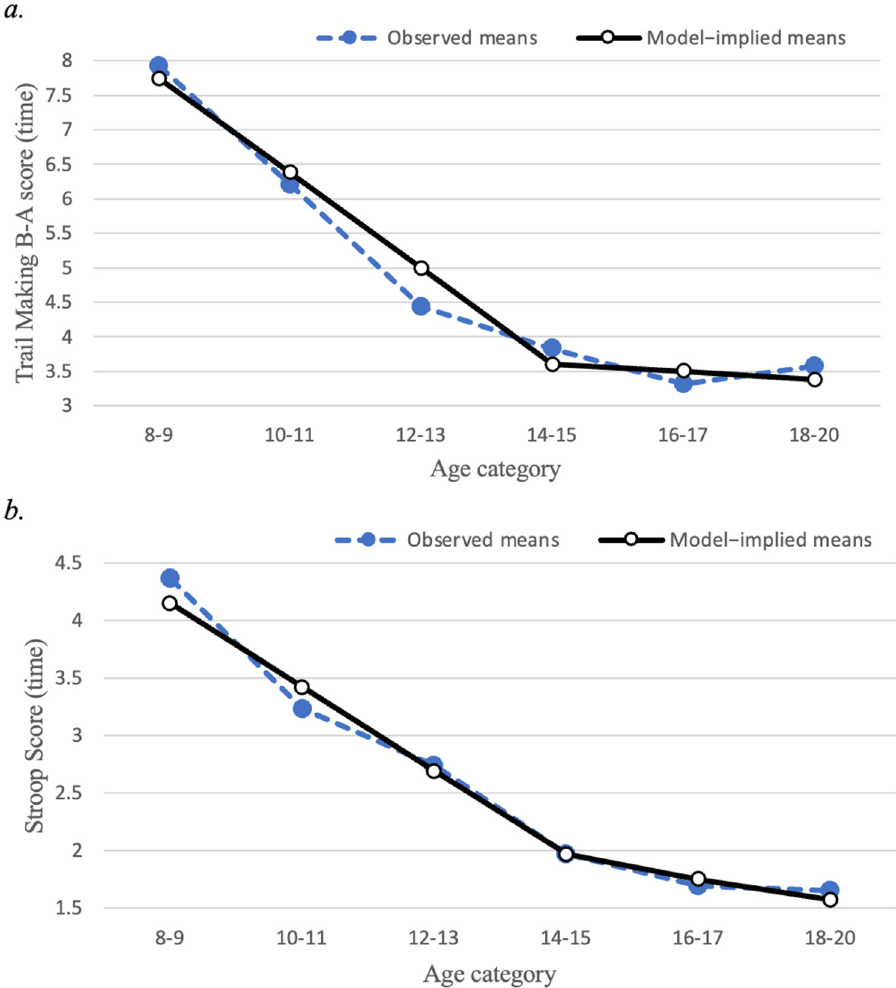
Figure 3. Mean trajectories for executive function task performance ( a ) Trajectory of Trail Making Task Part B minus Part A time; ( b ) Trajectory of Stroop Task interference time. Closed circles represent observed means; open circles represent model-implied means. Score reflects time (in seconds), where less time indicates better performance.